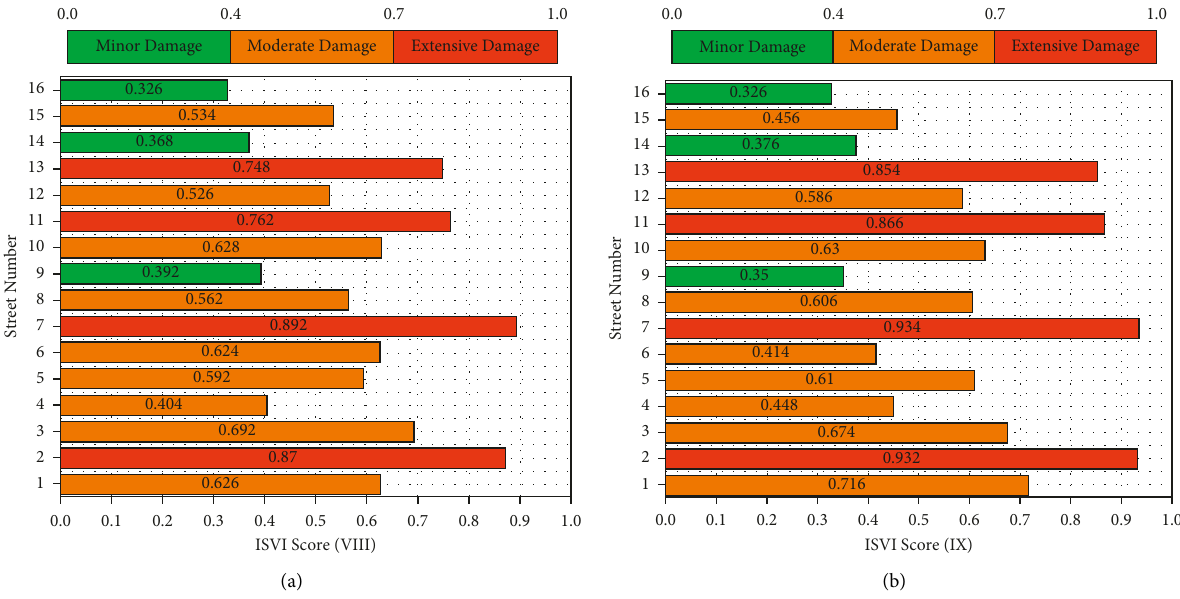
Figure 7: (a) ISVI scores for the investigated streets at seismic intensity (VIII). (b) ISVI scores for the investigated streets at seismic